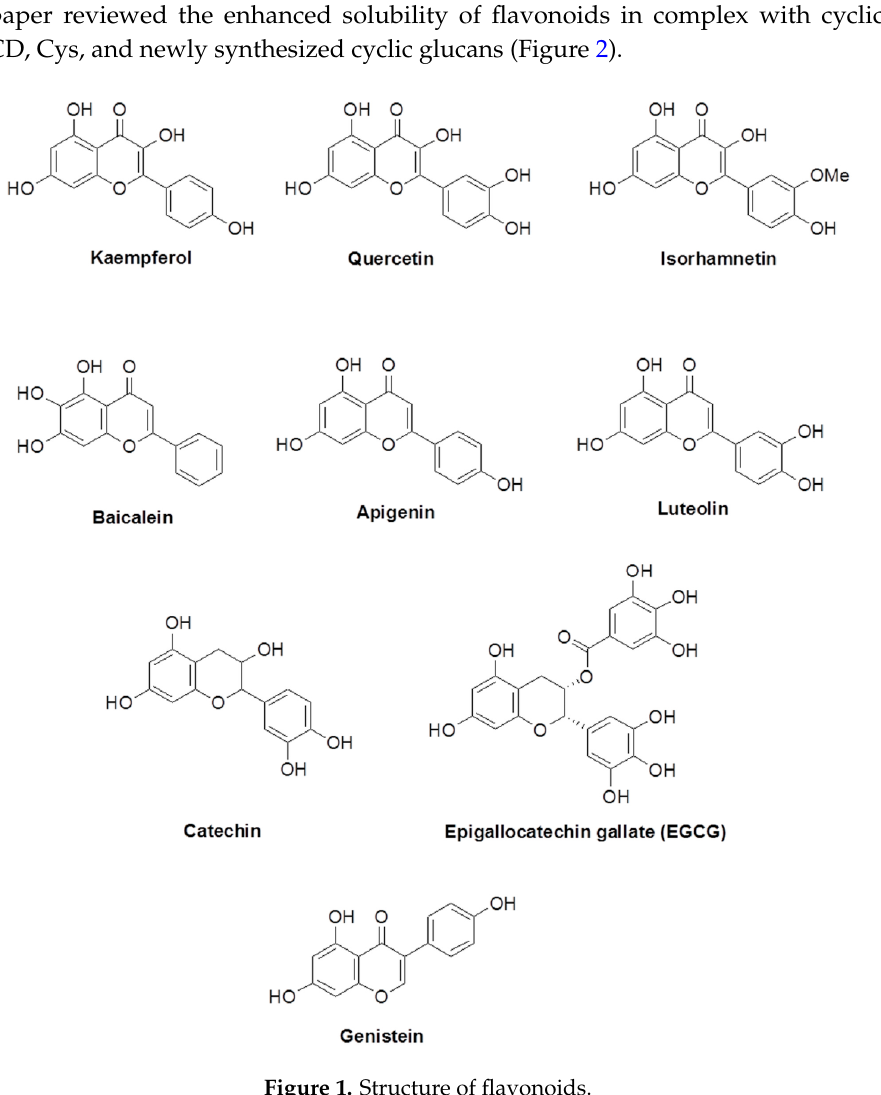
Figure 1. Structure of flavonoids.